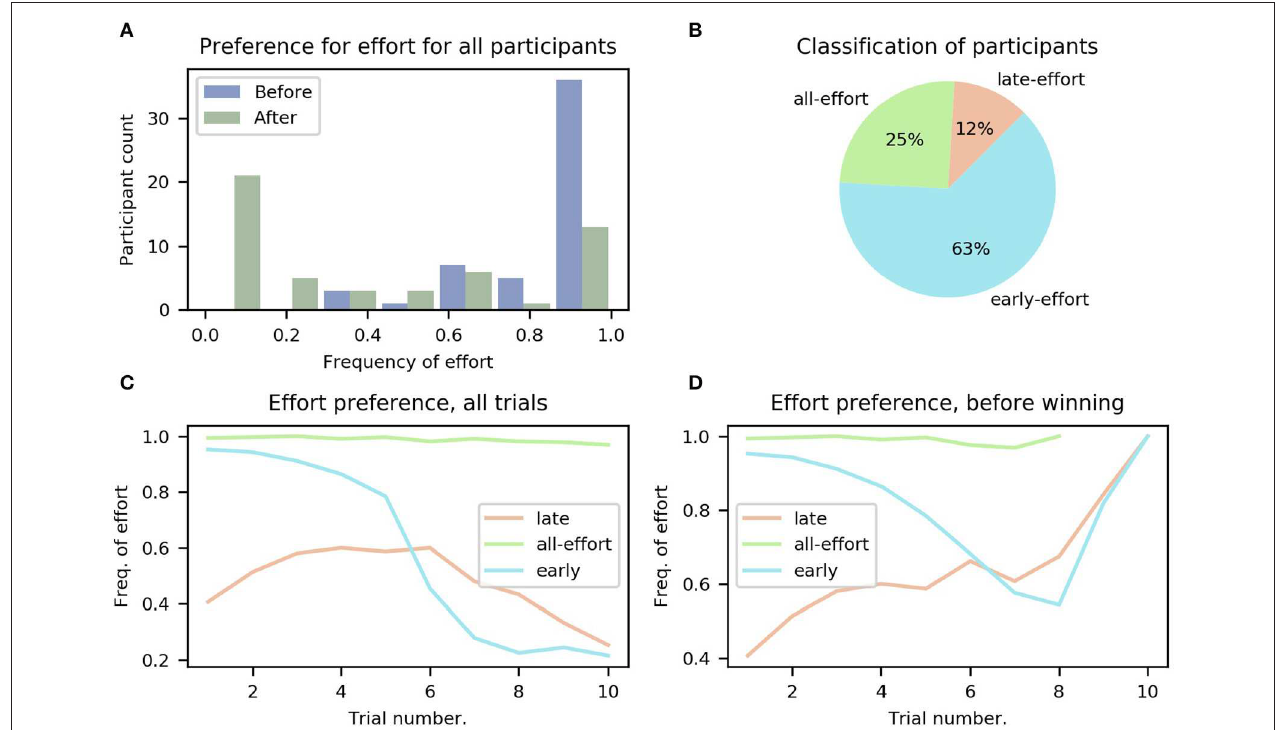
FIGURE 3 | Preference for effort for all participants. (A) Histogram of participants’ overall frequency of choosing effort averaged across all trials, separated into before (blue) winning the mini-block and after (green). (B) Classification of participants into the three groups: all-, early-, and late-effort; see main text. (C) Frequency of effort as a function of trial number for the three groups of participants, averaged over participants in each group. (D) Same as (C) , but only decisions made before the mini-block had been won are included. The different ranges of the lines (e.g., all-effort only reaches trial 8) is because participants who chose effort more often won the mini-block